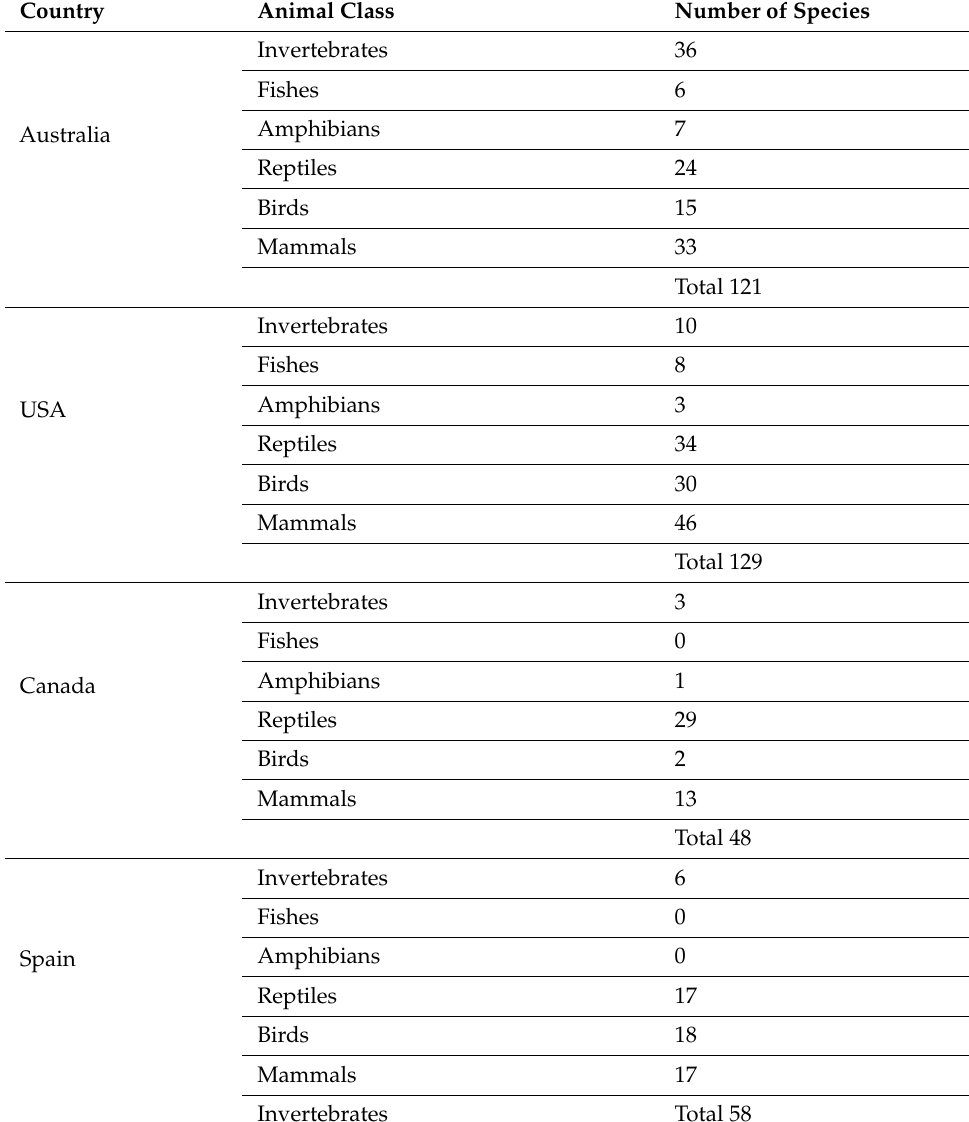
Table 2. Numbers of species by class for each surveyed